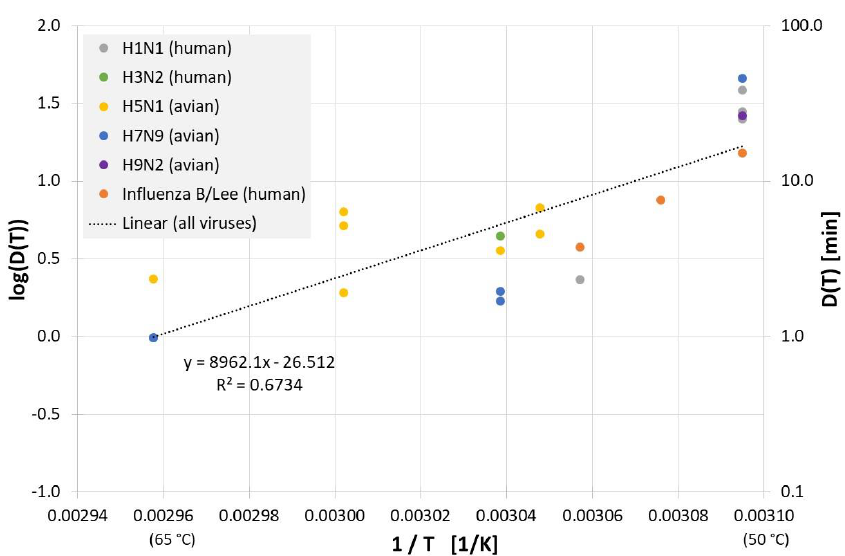
Figure 3. Correlation between 1/T and log(D(T)) for all published influenza virus thermal inactivation data in allantoic fluid along with the linear regression curve. For better understanding, D(T) is also given on the right Y-axis in a logarithmic scale.